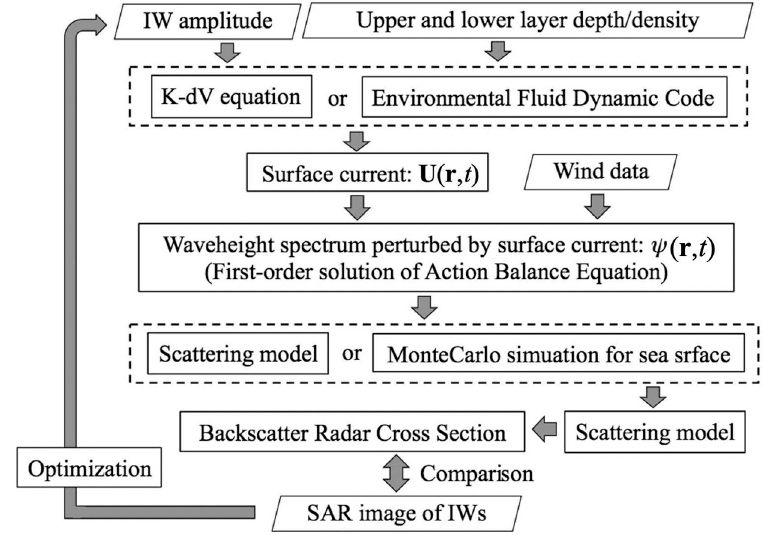
Figure 12. An example for the analysis of SAR images of IWs.